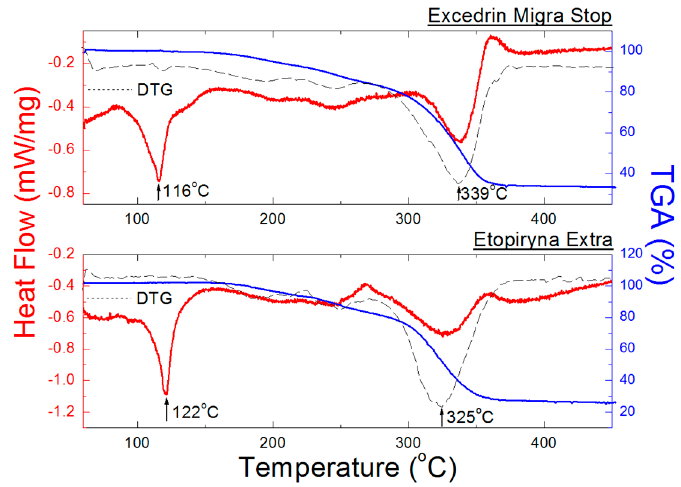
Figure 13. DSC and TGA/DTG curves of the drugs containing ACP, caffeine and ASA Excedrin Migra Stop and Etopiryna Extra.